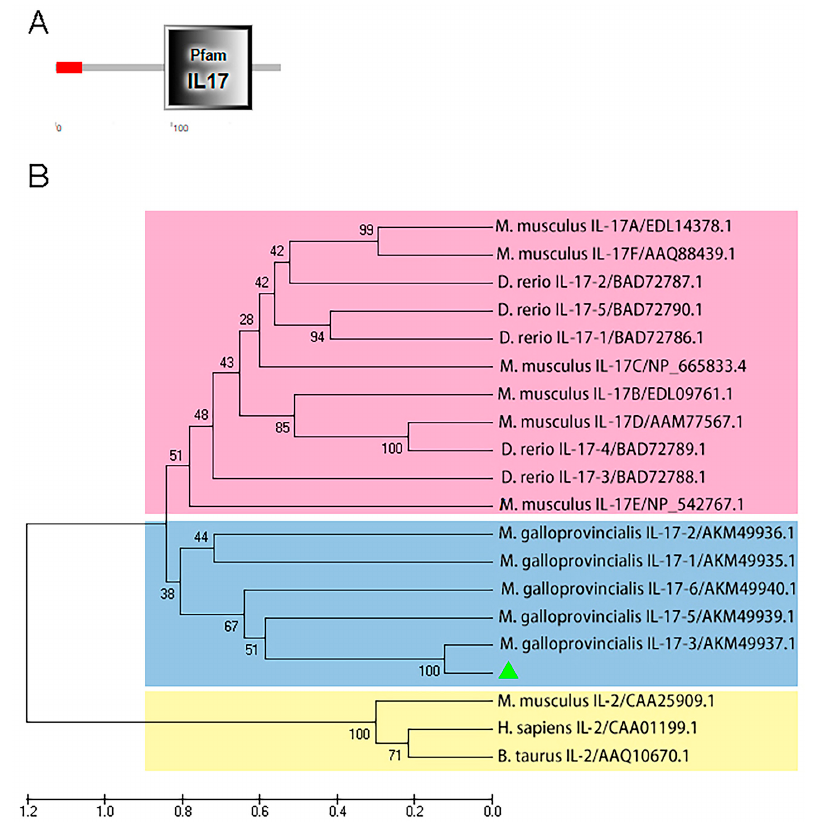
Figure 1. Molecular characterization of Mc IL-17-3. ( A ) Architecture analysis of conserved domains in Mc IL-17-3 using SMART. A conserved IL-17 domain was shown. ( B ) Phylogenetic analysis of Mc IL-17-3. The phylogenetic tree was constructed using MEGAX software with 2000 replications of bootstrapping using the neighbor-joining method. Mc IL-17-3 was labeled with a green triangle. Species included in the phylogenetic tree were all retrieved from the Genebank database, and accession numbers were also listed in the tree. Green triangle on behalf of Mc IL-17-3. (For interpretation of the references to color in this figure legend, the reader is referred to the Web version of this article.).